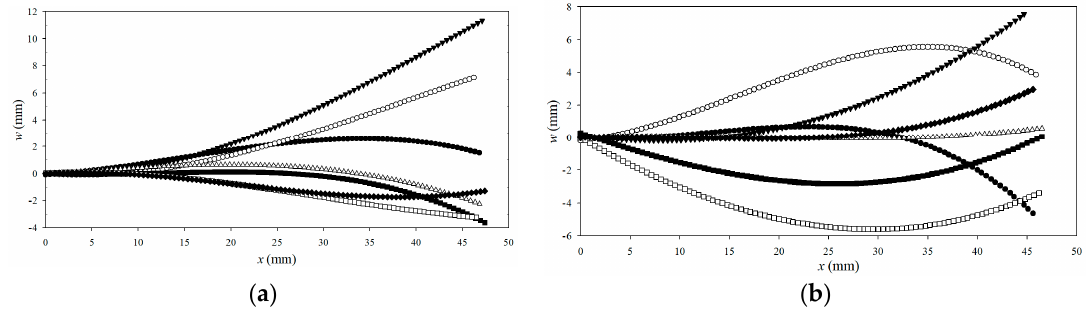
Figure 8. Water tunnel data characteristic deflected shapes t p = 80 µm, W = 5 mm, L = 50 mm ( a ) RE = 8025; ( b ) RE = 13,245.